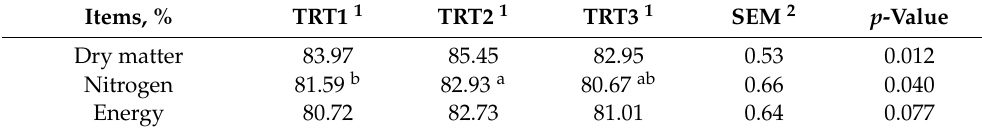
Table 3. Effect of blood plasma and yeast supplementation on nutrient digestibility of weaning pigs 1